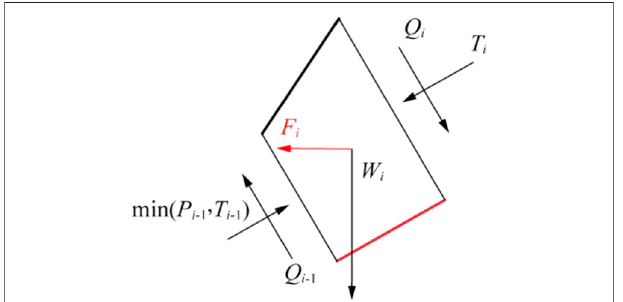
FIGURE 5 | Limit equilibrium analysis of rock mass toppling failure in stratum layer # i under horizontal pseudo-static load.